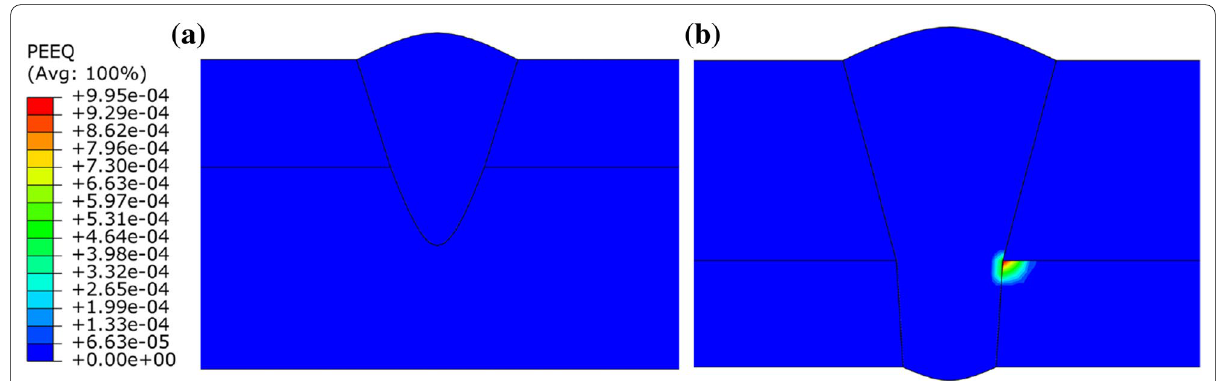
Figure 12 Equivalent plastic strain (PEEQ) in cross-section of a 0.8